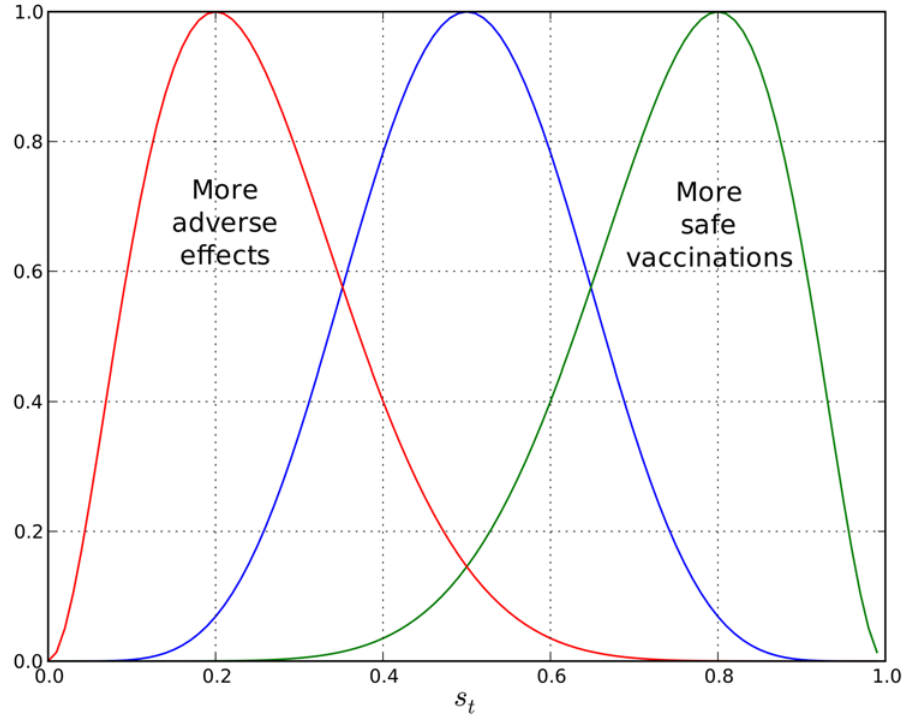
Figure 6. Updating the perceived probability of a safe vaccination. The expected value of s t will change towards one with more safe vaccines witnessed and in the opposite direction with the accumulation of vaccine adverse effects (VAE) events. Y-axis are arbitrary units.